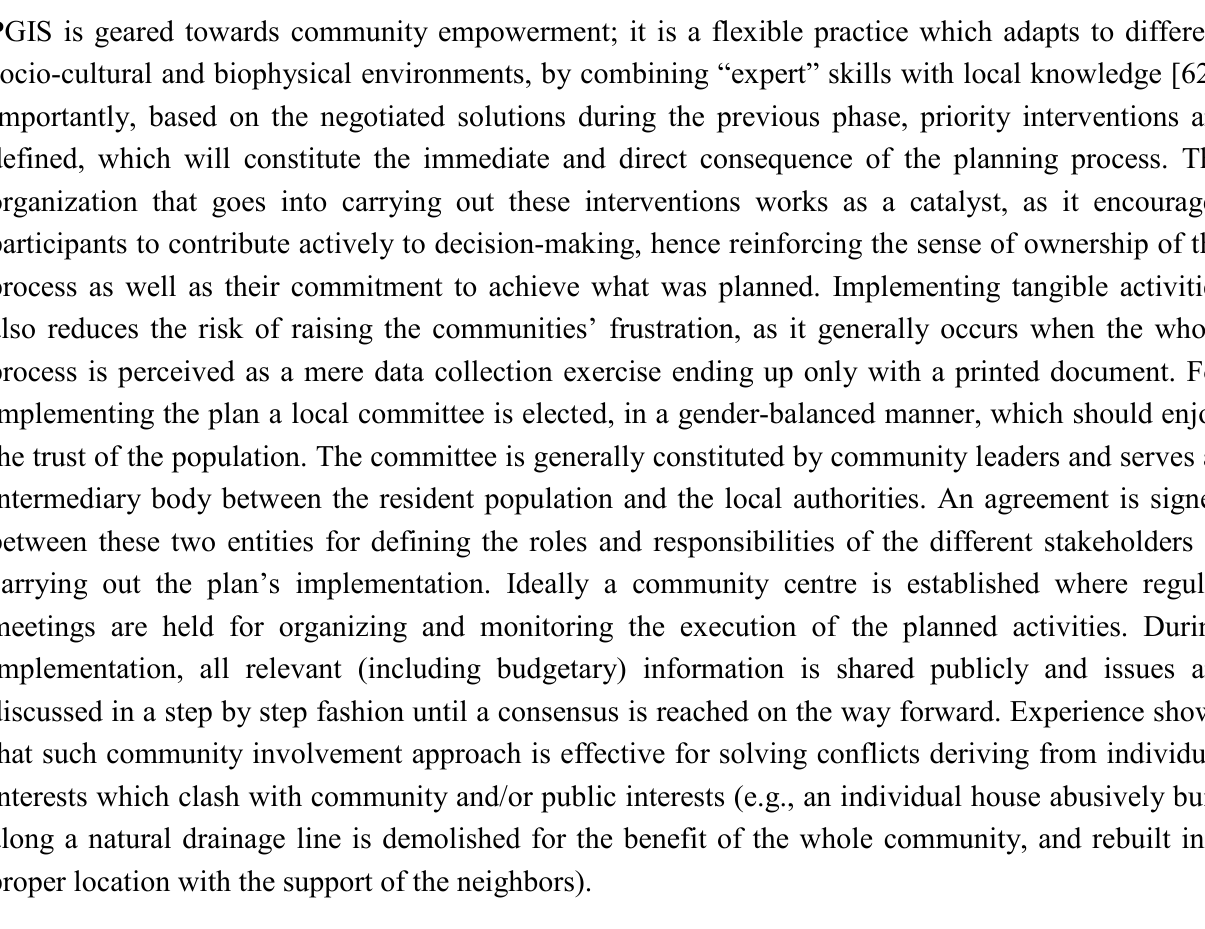
Figure 8. Local Participatory Plan for Chikwarakwara area, Matabeleland South, Zimbabwe.